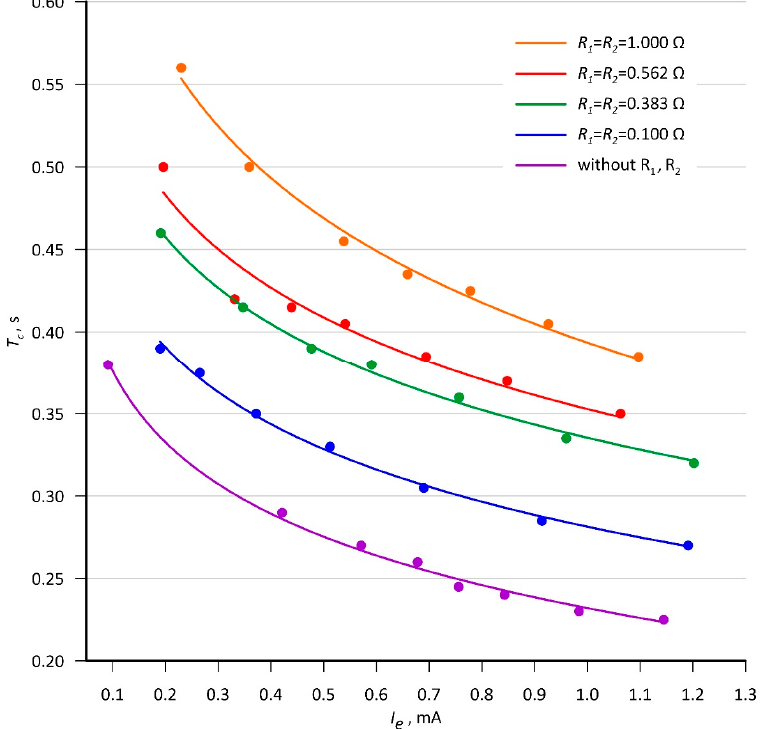
Figure 7. Dependence of the time constant T c as a function of the intensity I e of the emission current, at selected values of the sensing resistors, for thoriated tungsten cathode ( d = 0.00012 m and l = 0.045 m) and V a = 100 V.